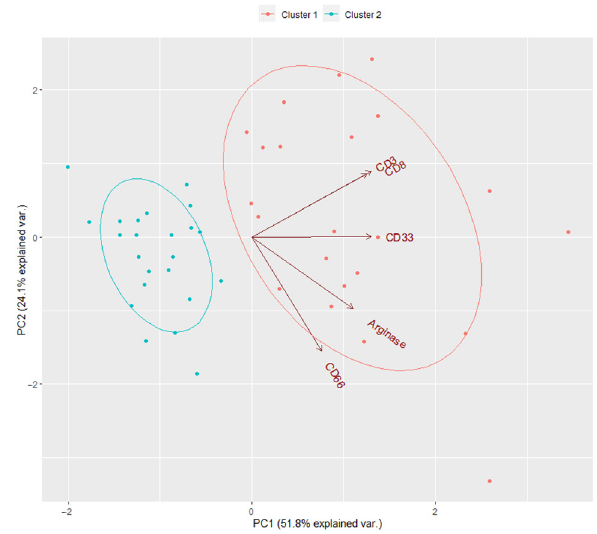
Figure 2. The biplot of unsupervised K-means analysis for myeloid Arginase S , CD33 S and CD66 S and T-cell CD3 S and CD8 S .